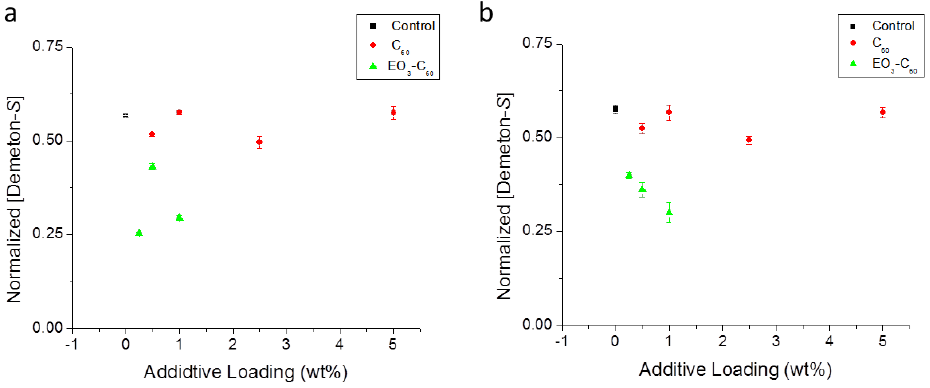
Figure 6. Demeton- S recovered from Tecoflex films after 18 h residence in dark ( a ) and daylight ( b )